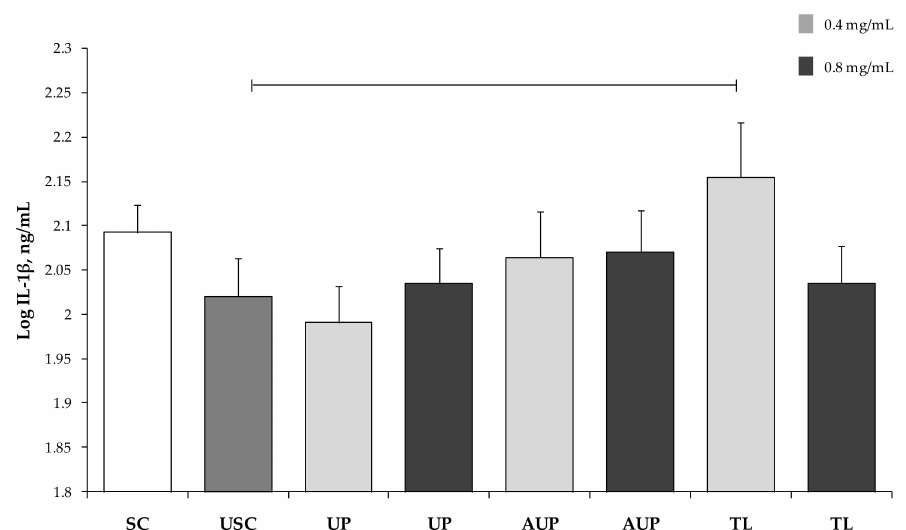
Figure 5. Interleukin (IL)-1 β secretion by PBMCs stimulated with ConA and LPS and cultured with the unsaponified fraction (UP), the acetylated unsaponified fraction (AUP), and the total lipids fraction (TL) extracted and purified from C. sorokiniana . For each treatment, 0.4 mg/mL and 0.8 mg/mL were tested on PBMCs. PBMCs with ConA and LPS were stimulated cells (SC), and PBMCs without ConA and LPS were unstimulated cells (USC). Data were analyzed by one-way ANOVA and Fisher post-hoc test and are presented as least squares mean ± SEM. Bar indicates p < 0.05.